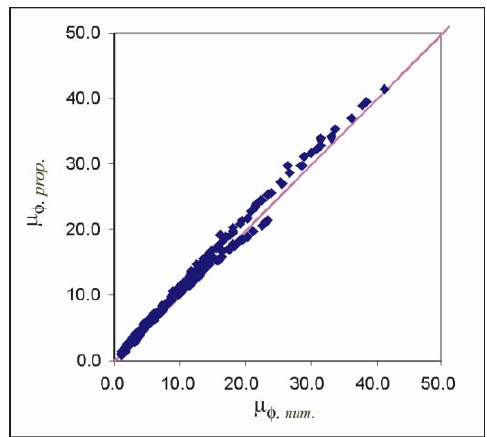
Fig. 5. Proposed curvature ductility values using Eq. (21) versus numerical analysis